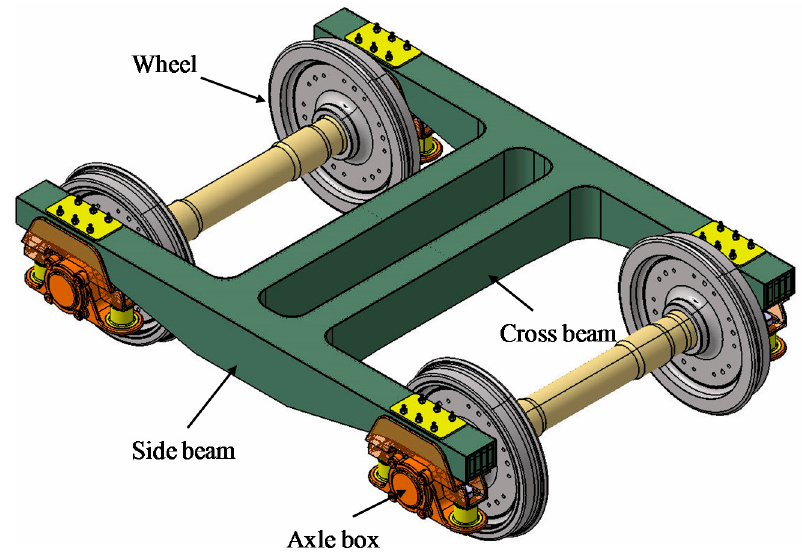
Figure 2. Bogie frame of urban subway train manufactured using composite material.